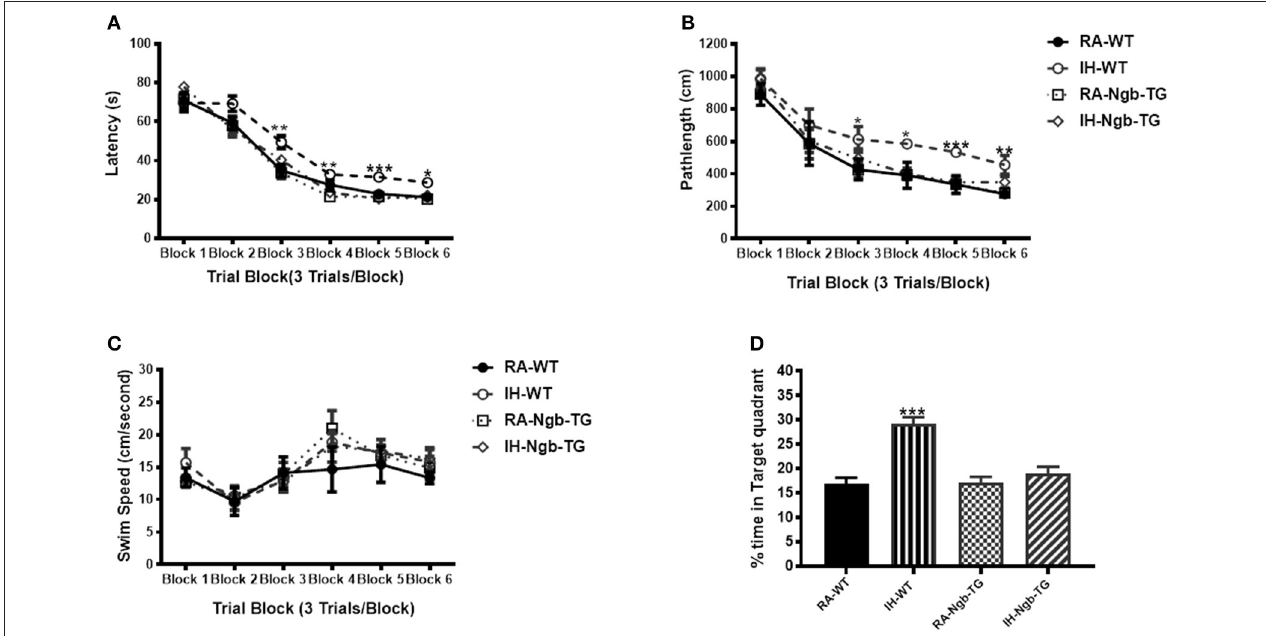
FIGURE 3 | Ngb-TG mice exposed to IH do not exhibit deficits in spatial task acquisition and retention in the Morris water maze. (A,B) Mean latencies (s) and pathlength (cm) to locate the submerged platform during spatial task training in WT and Ngb-TG exposed to either intermittent hypoxia (IH) or to room air (RA) ( n = 14 per group). (C) Swim speed (D) Mean percentage time in the target quadrant during probe trial after completion of water maze testing in either WT and Ngb-TG exposed to IH or maintained in RA. ( n = 14/experimental group; * P < 0.05, ** P < 0.001, *** P < 0.0001 vs. RA-WT).